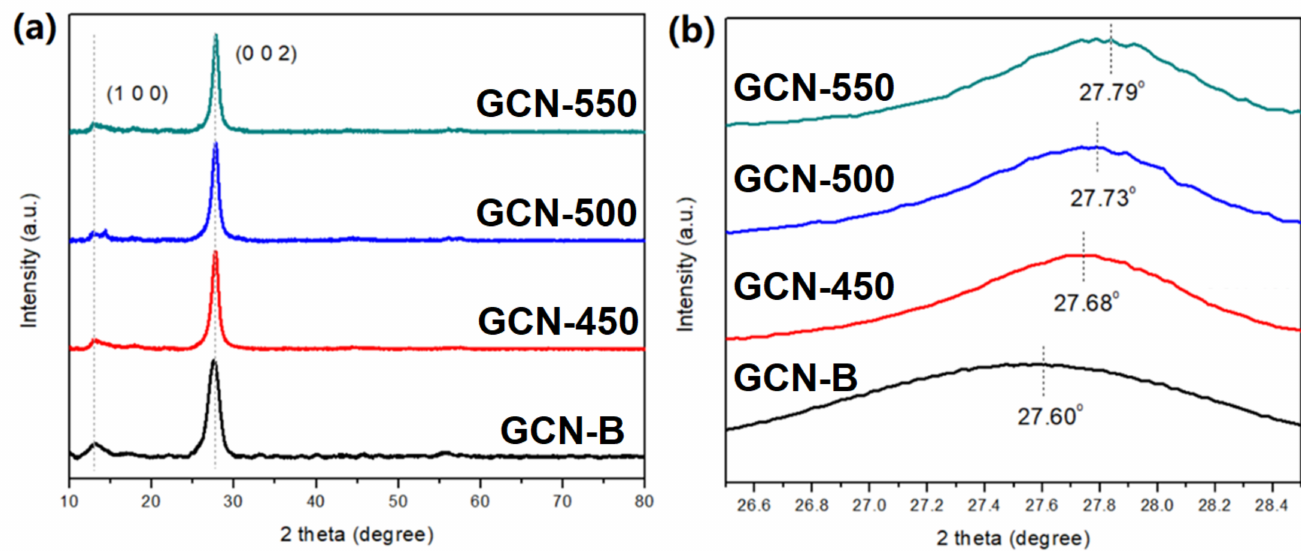
Figure 3. ( a ) XRD diffractogram of GCN-B and GCN that recalcined at different temperatures; ( b ) the enlarged peak of